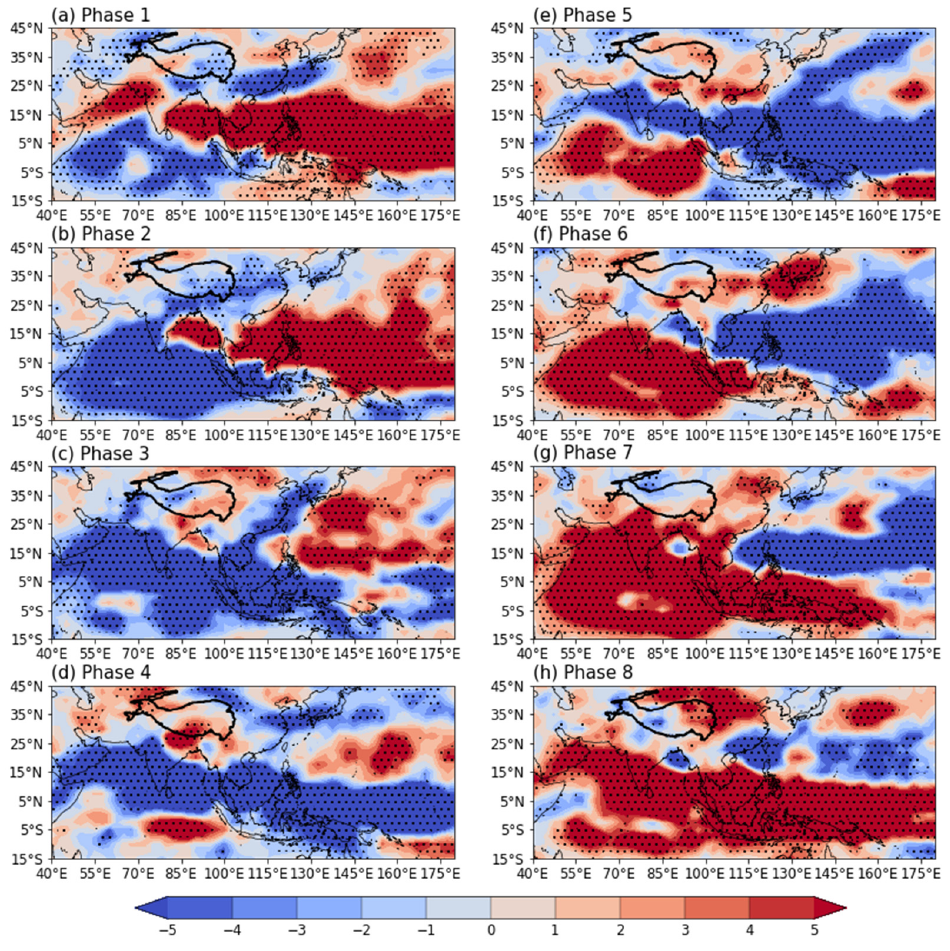
Figure 2. Composite patterns of OLR anomalies (shading) (W m − 2 ) in MJO Phases 1–8 ( a – h ). The dots indicate that the values are statistically significant at the 95% confidence level. The thick black curves illustrate TP.